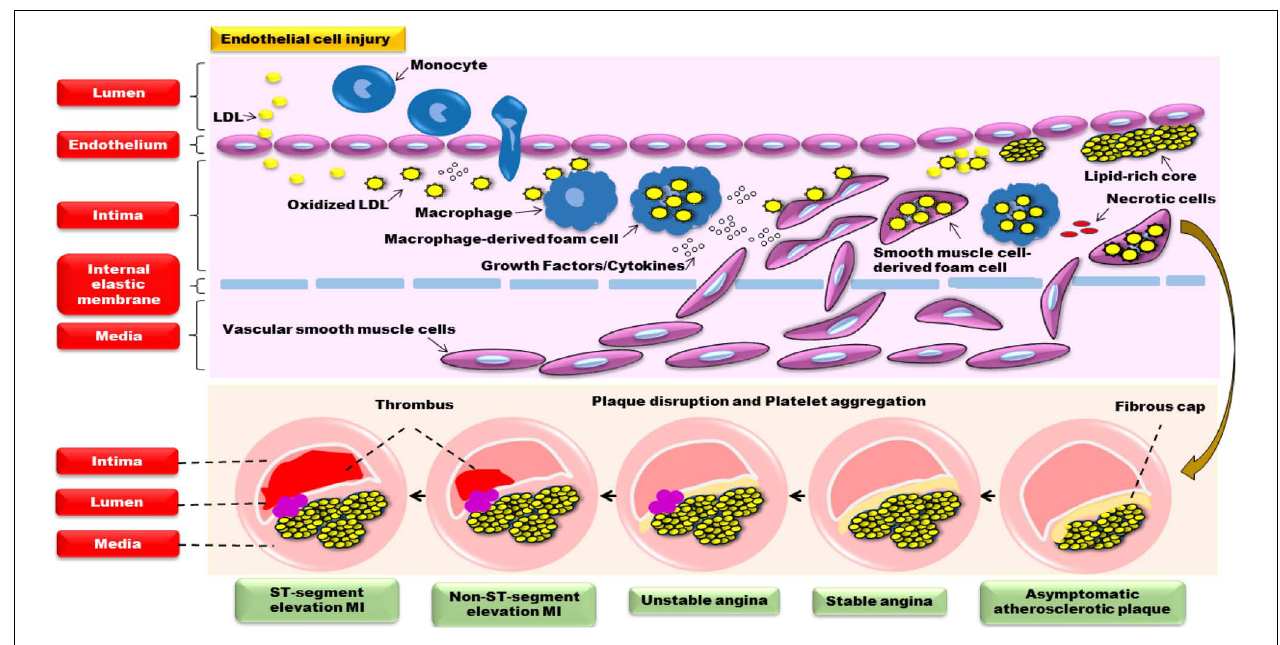
FIGURE 1 | The pathological mechanism of atherosclerosis in